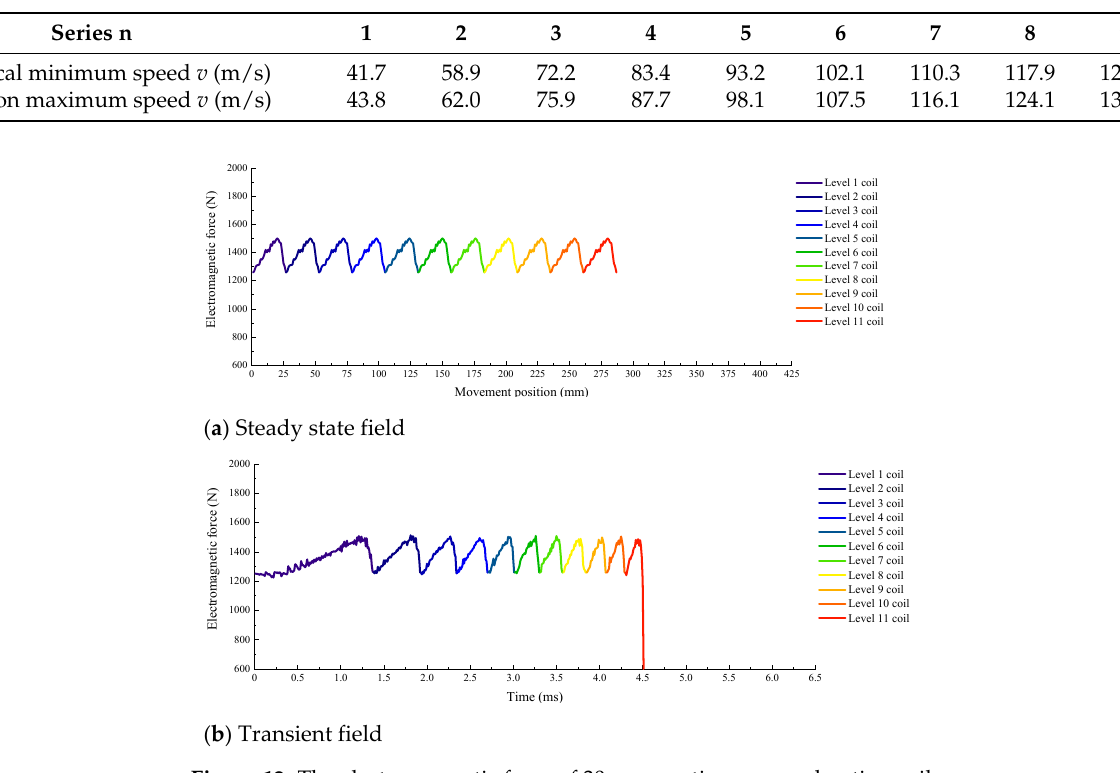
Figure 12. The electromagnetic force of 30 mm continuous acceleration coil.